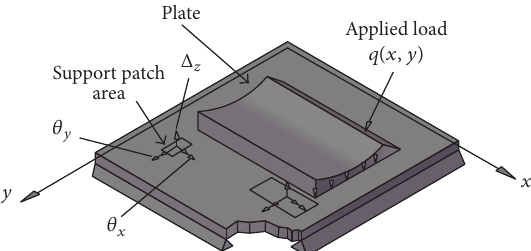
Figure 2: Simply supported rectangular plate with internal sup-